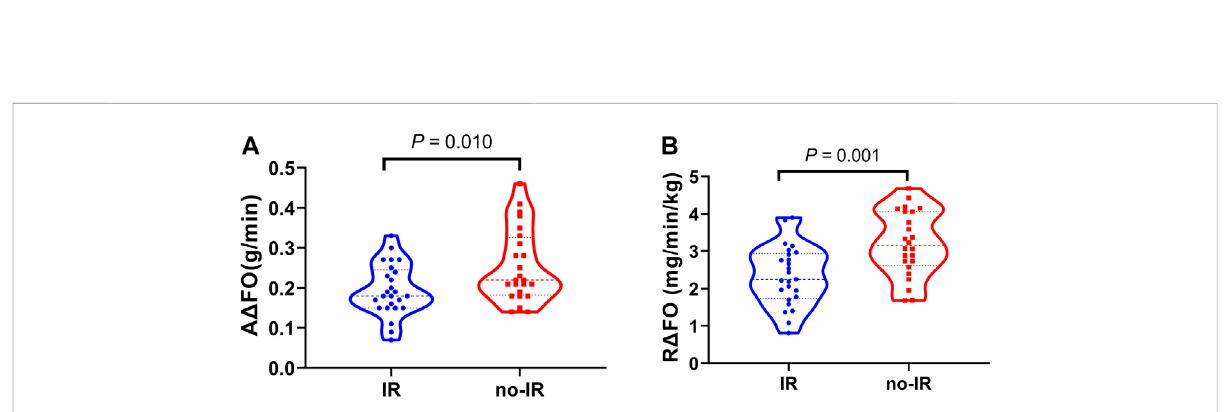
FIGURE 5 Fat metabolic fl exibility between IR and no-IR groups. Violin plot of fat metabolic fl exibility between IR and no-IR group. (A) : Absolute fat metabolic fl exibility (A Δ FO) between IR and no-IR groups; (B) : Relative fat metabolic fl exibility (R Δ FO) between IR and no-IR